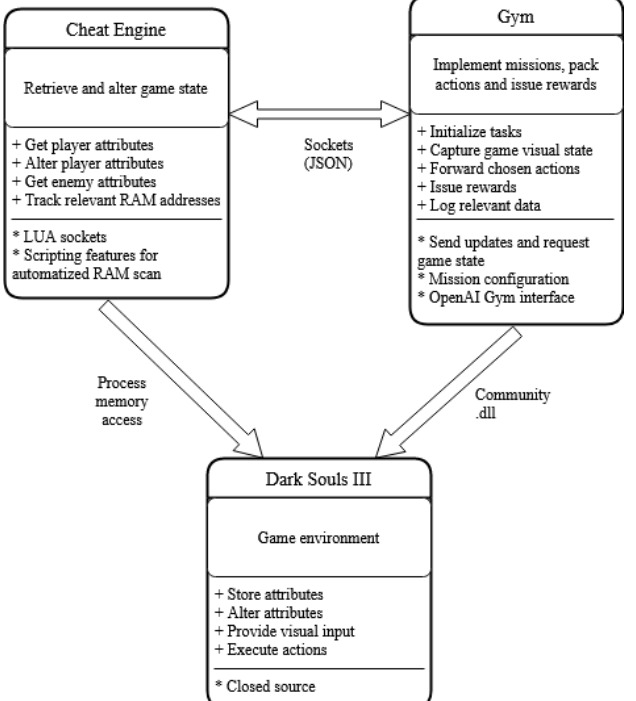
Figure 2. System architecture highlighting main software components for the training and testing environment, as well as main functions and attributes.